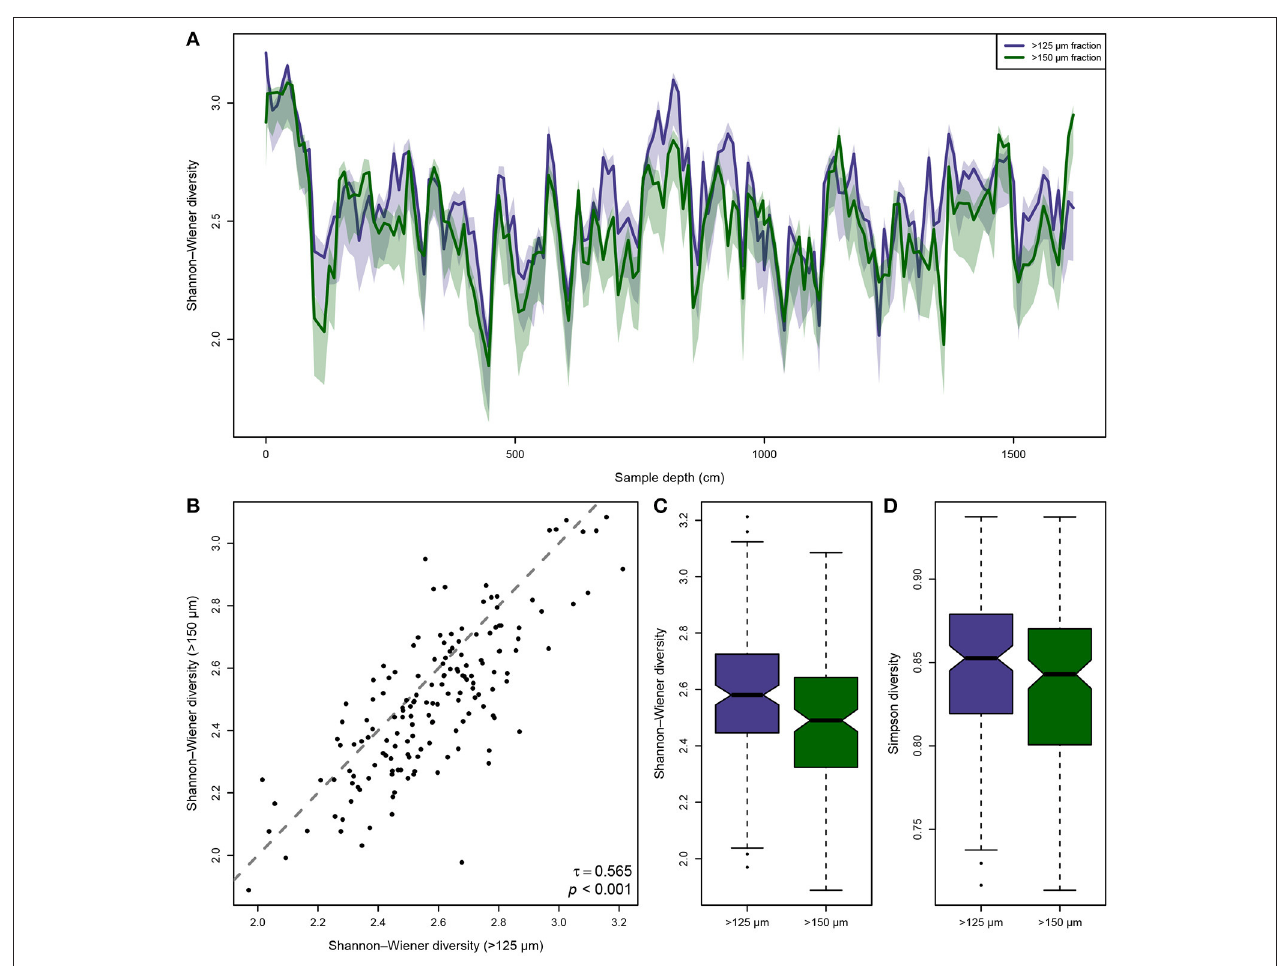
FIGURE 2 | Differences in observed biodiversity of the benthic foraminiferal assemblages between the >125 and >150µm size fraction from the Pefka E section. (A) Shannon–Wiener biodiversity (with bias-correction for incomplete sampling) of both size fractions along the entire section (lines) including its bootstrapped 95% confidence interval (shaded area). The observed biodiversity in the >125µm fraction is mostly but not consistently higher than in the >150µm size fraction, and in considerable parts of the section there is no overlap between the 95% confidence intervals of the size fractions. (B) Kendall rank-order correlation between the individual Shannon–Wiener biodiversity values per sample in both size fractions. The correlation is significant, but the correlation coefficient is rather low, indicating consistent trends but larger differences in the details between the size fractions. The gray, dashed line indicates the identity function ( x = y ). (C,D) Notched boxplots of the individually observed Shannon–Wiener biodiversity (C) and Simpson biodiversity (D) values per sample in both size fractions. Horizontal line depicts median, boxes indicate interquartile range (IQR), whiskers extend to 1.5 × IQR, outliers are marked by black